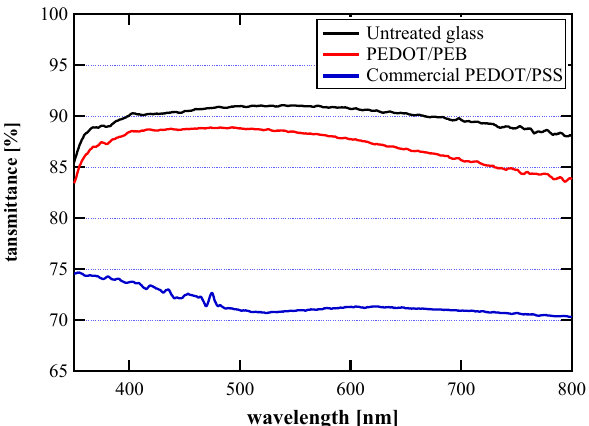
Figure 1. Optical transmittance spectra of the polyethylene dioxythiophene on polyelectrolyte brush (PEDOT/PEB) sample, commercial polyethylene dioxythiophene and polyethylene sulfonic acid (PEDOT/PSS) film and untreated glass. The PEDOT/PEB sample exhibited remarkably high transparency.